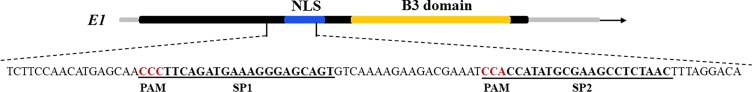
Gene structures of E1 with target sites. The underlined bases indicate the target sequences, and the red letters indicate PAM sequences.